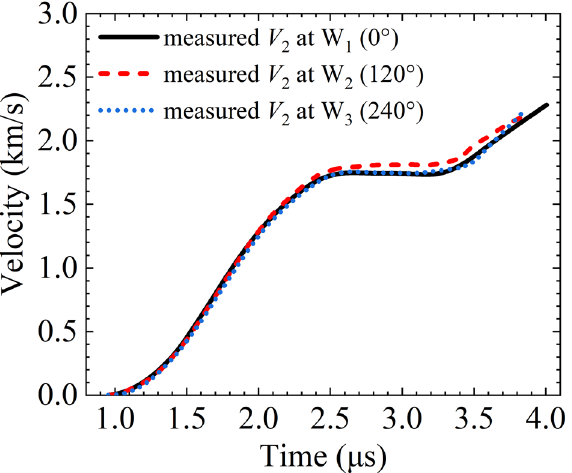
Figure 7. V 2 measured with the external photonic Doppler velocimetry probes versus